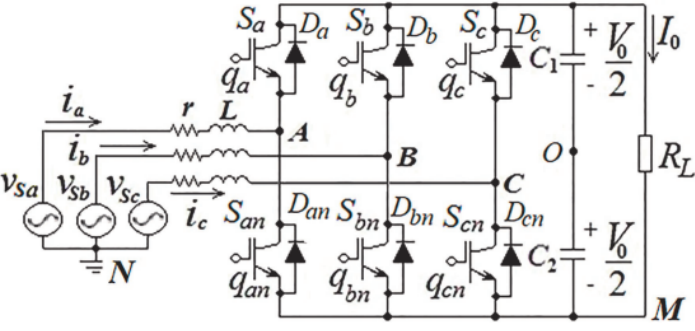
Figure 2. Three phase, PWM